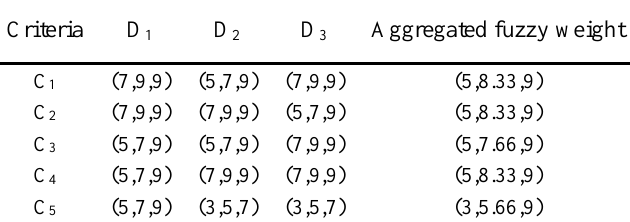
Table 5. Aggregate fuzzy weight for